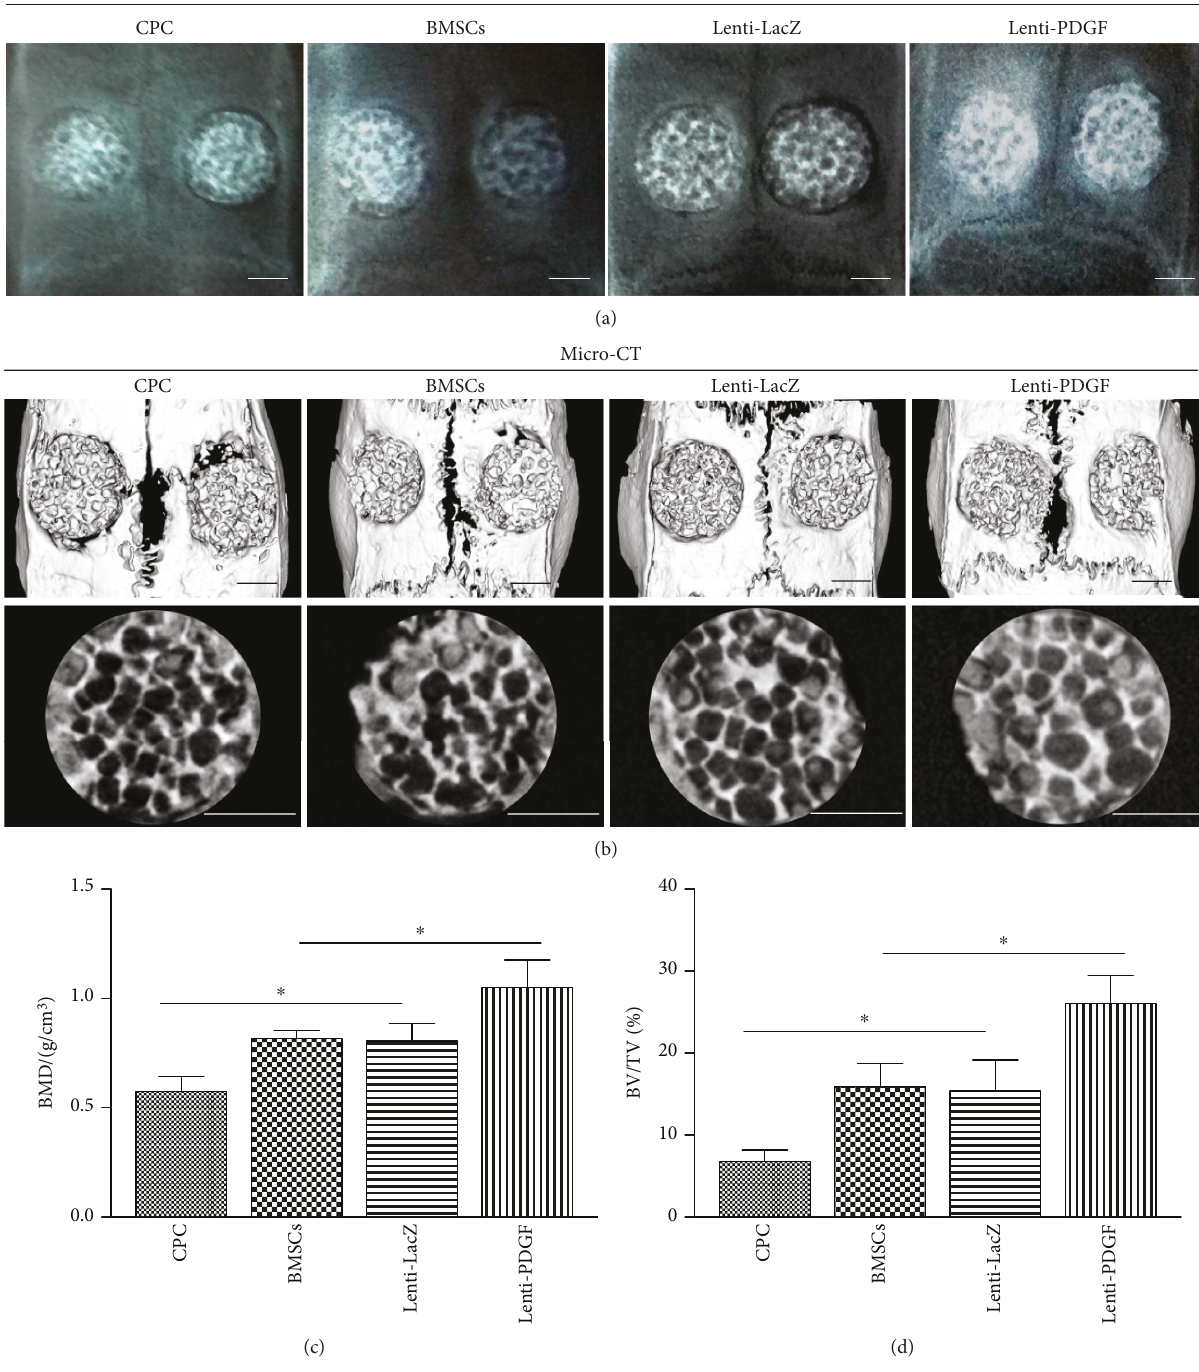
Figure 6: Radiography and micro-CT analysis. (a) Radiographic evaluation of the repaired skulls at 8 weeks. (b) 3D reconstruction images showing the reparative e ff ect of the CPC, CPC with BMSCs, CPC with Lenti-LacZ-modi fi ed BMSCs, and CPC with PDGF-B-modi fi ed BMSCs. (c, d) Bone mineral density (BMD) and bone volume/total volume (BV/TV) analysis in each group. Scale bar: 2 mm; ∗ P < 0 05